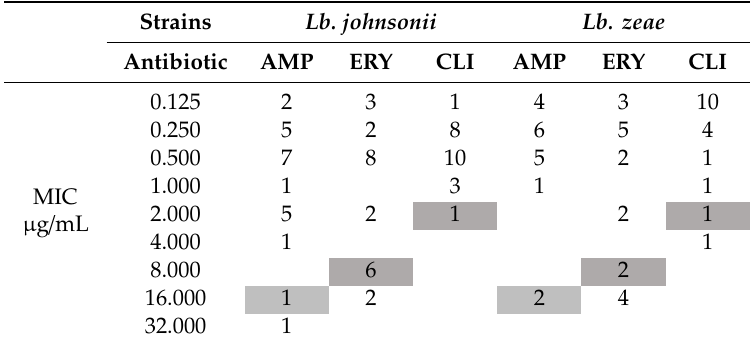
Table 4. MIC determination of Lb. johnsonii and Lb. zeae isolates using the broth dilution method.